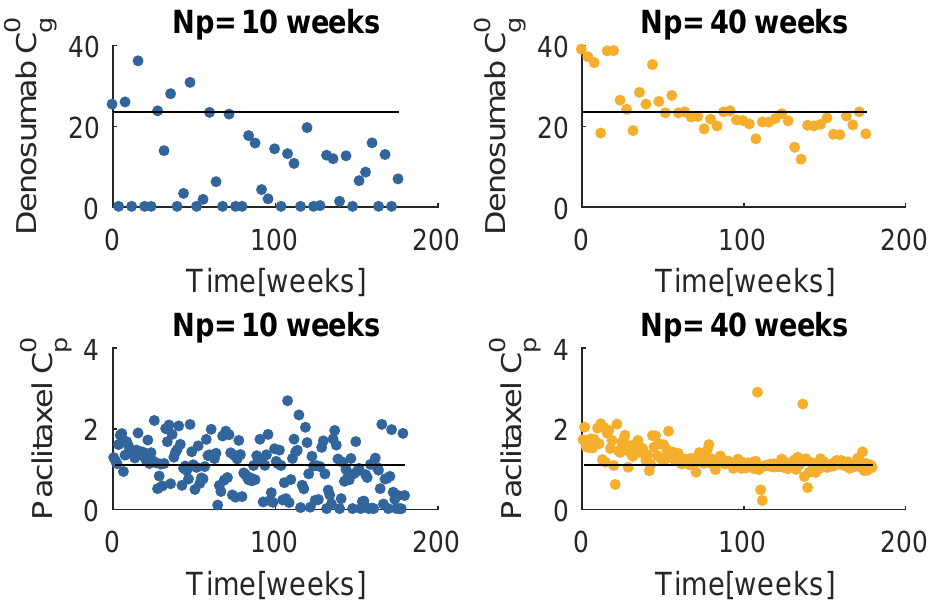
Figure 10. Best obtained prescriptions in mg with the model M DR 2